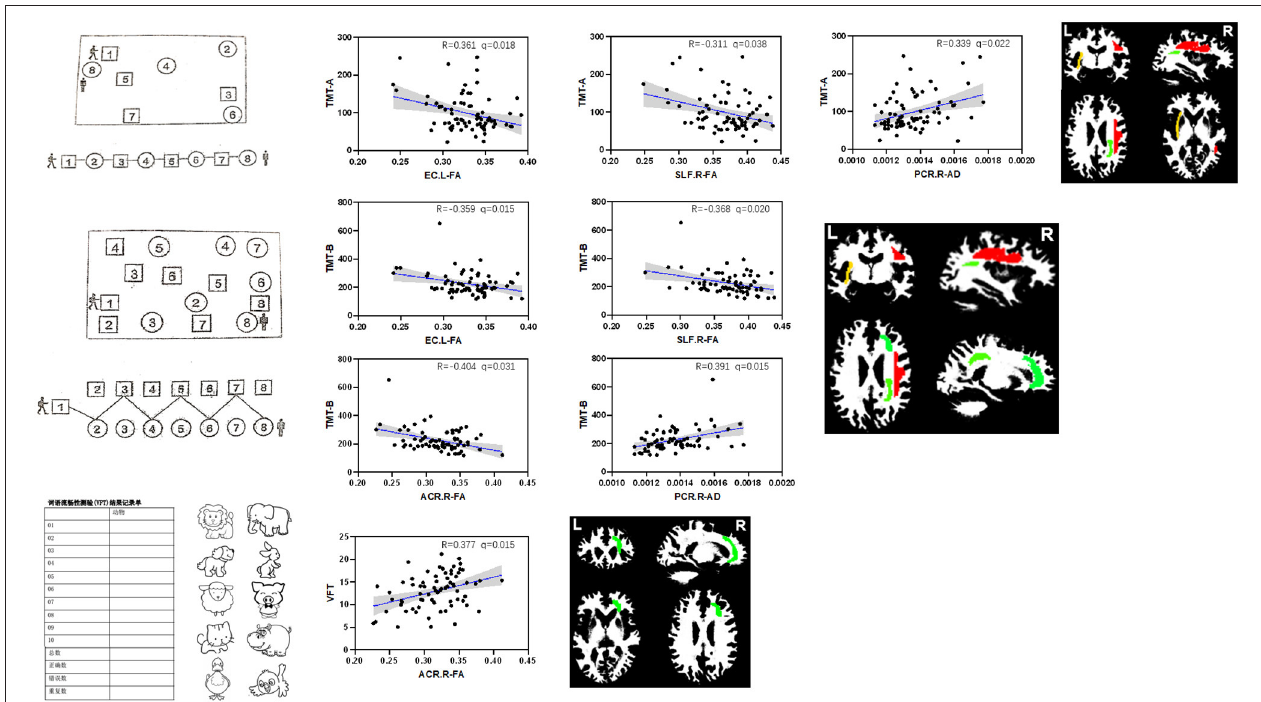
FIGURE 3 | Correlations between discriminative features and executive function tests within vMCI group, controlled for gender, age, and education. All results were corrected by FDR. The mean AD value of right PCR ( r = 0.339, P < 0.037) and the mean FA values of the left EC ( r = − 0.361, P < 0.026) were significantly associated with TMT-A; the mean FA values of the right ACR ( r = − 0.404, P < 0.026), left EC ( r = − 0.359, P < 0.026) and right SLF ( r = − 0.368, P < 0.026), and the mean AD value of right PCR ( r = 0.391, P < 0.026) were significantly associated with TMT-B; the mean FA values of the right ACR ( r = 0.377, P < 0.026) were significantly associated with